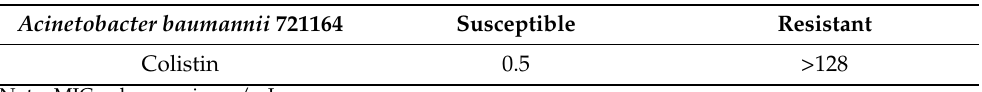
Table 1. Minimal inhibitory concentration (MIC) of colistin of the investigated A. baumannii 721164 determined by broth microdilution.